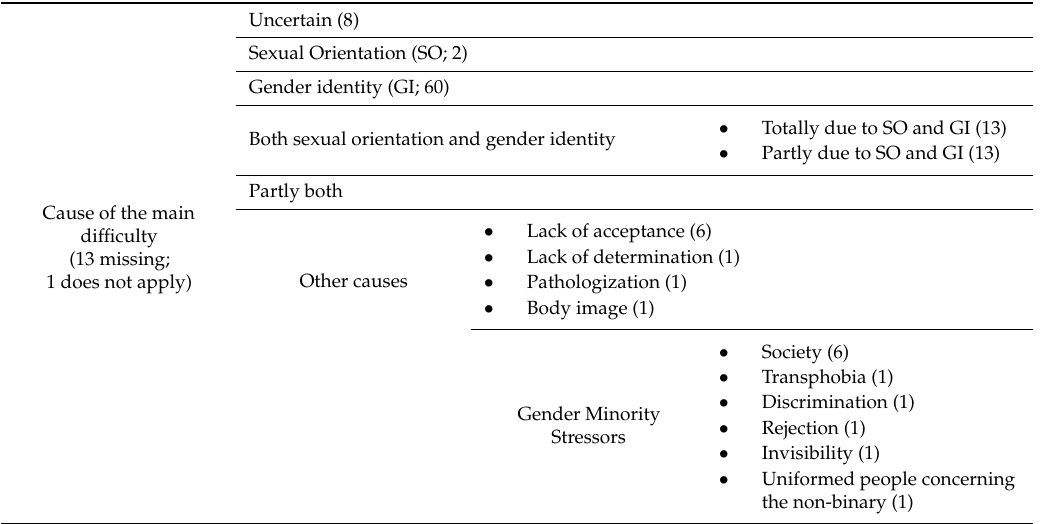
Table 4. Main themes and respective codes regarding the question “Do you think that the cause of this di ffi culty is your sexual orientation or your gender